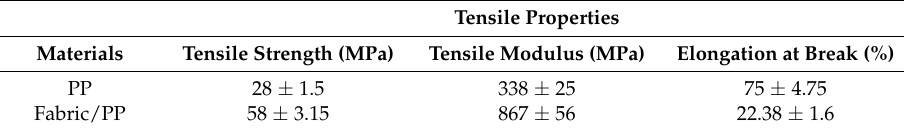
Table 1. Tensile properties of polypropylene (PP) and fabric/PP composites.